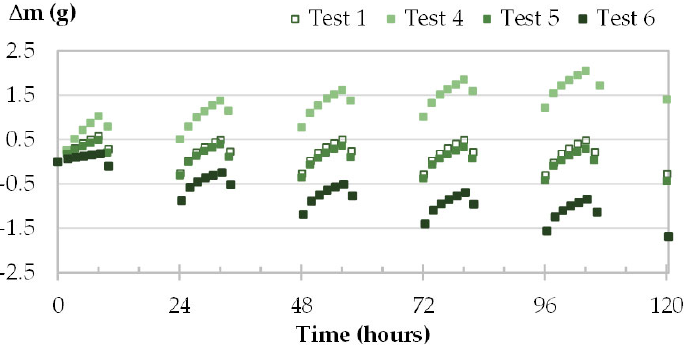
Figure 15. Moisture uptake and release for one specimen of TH (TH-c-4) at different initial conditioning.